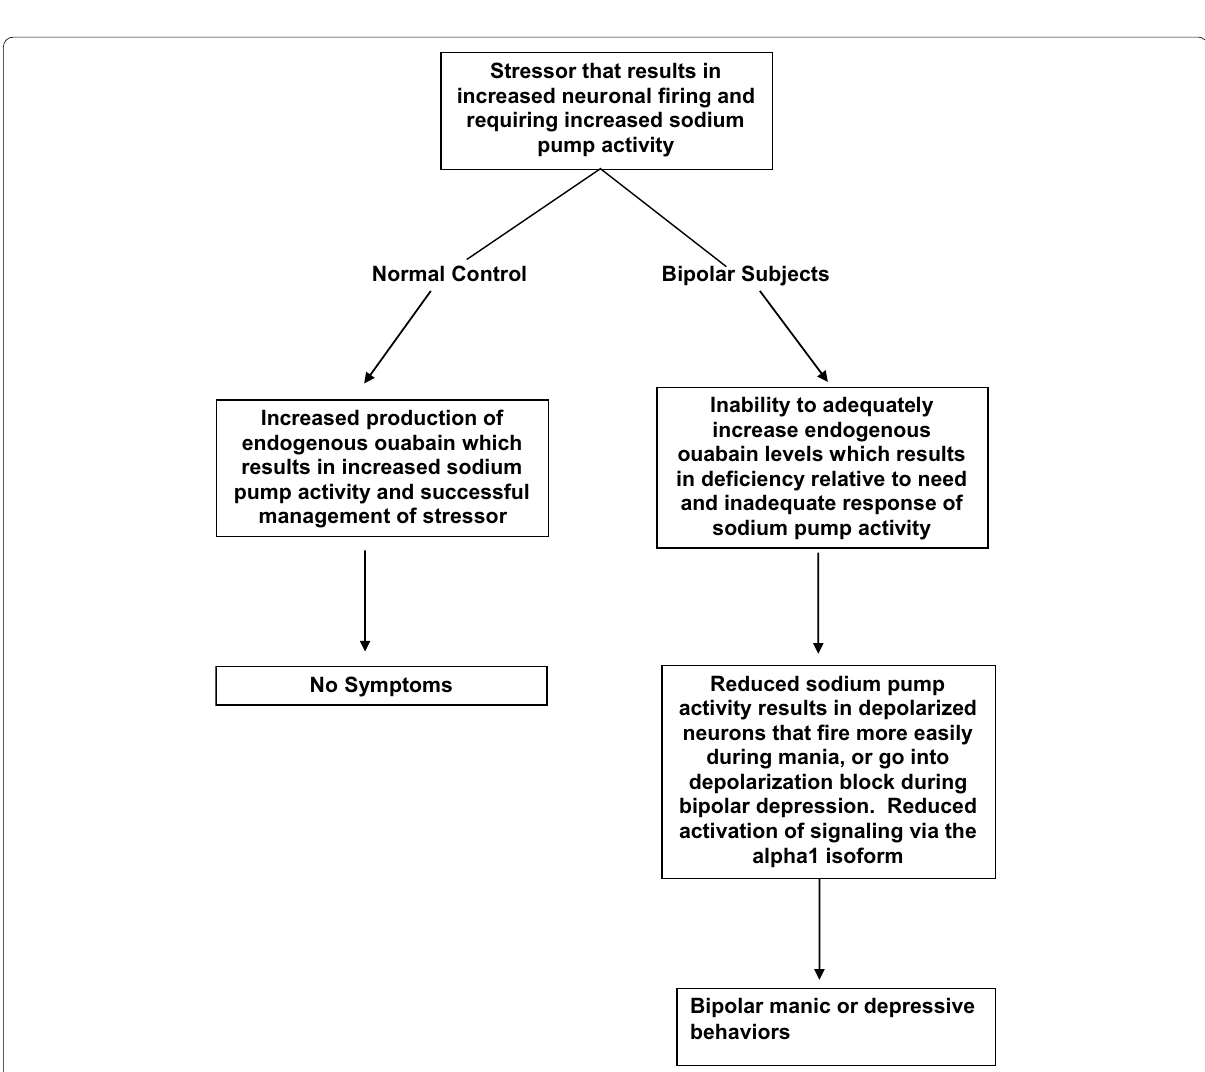
Fig. 1 Proposed model of role of endogenous ouabain in pathophysiology of bipolar